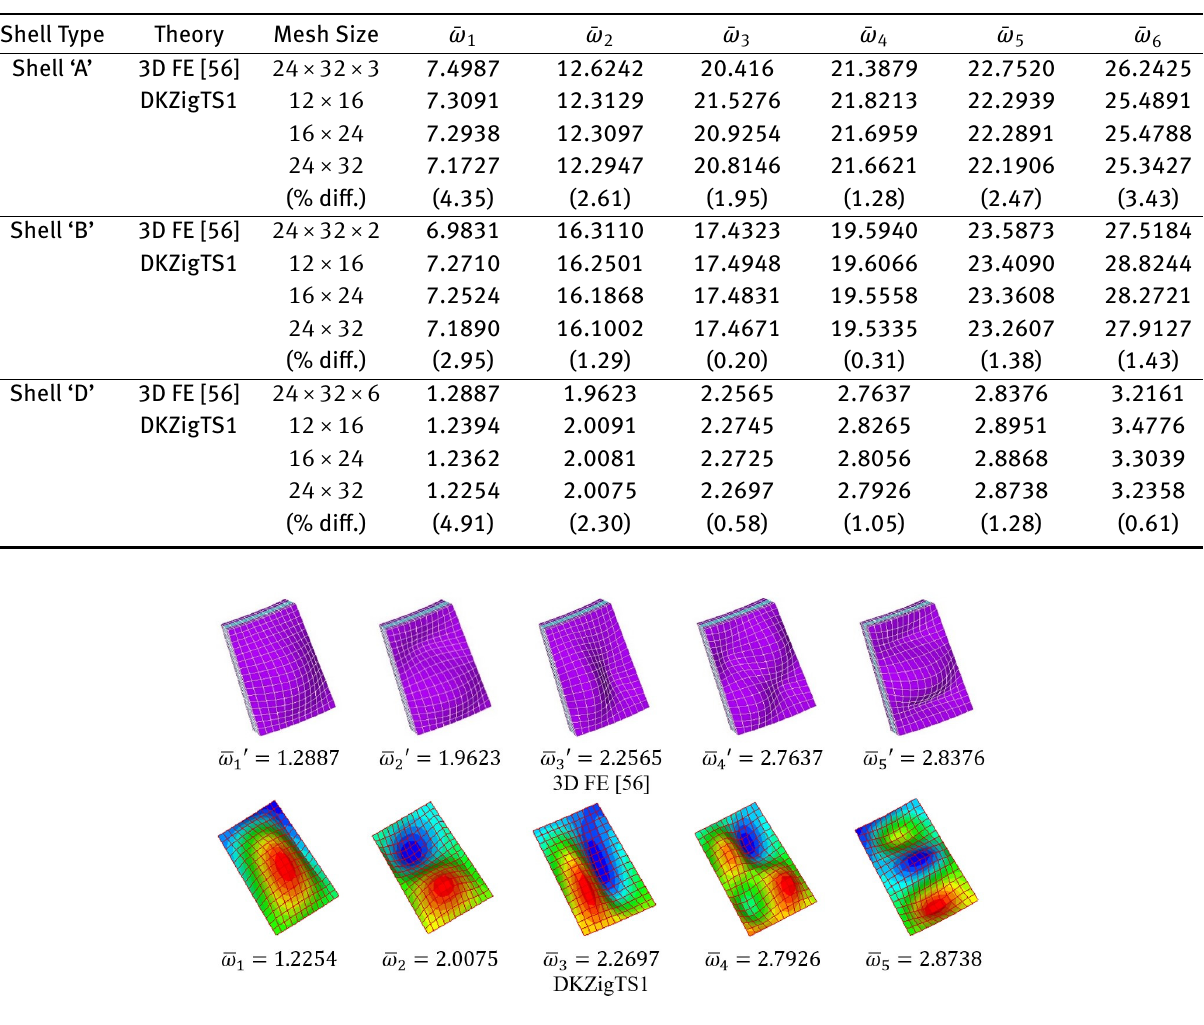
Figure 9: Comparison of first five mode shapes for all round simply supported sandwich conical shell panel ‘D’, h / a = 0.125 , S / a = 10 , 𝛾 o = 15 ∘ and 𝛾 v = 30